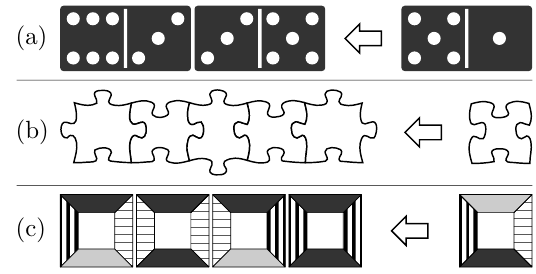
Figure 2. Wang tiles concept, a) domino game, b) jig- saw puzzle, c) Wang tiles.